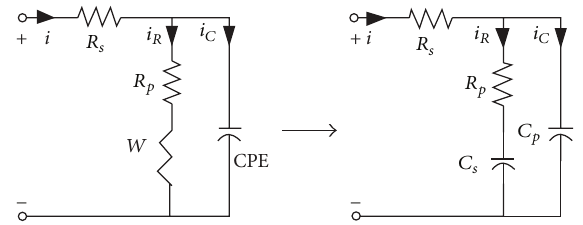
Figure 8: Equivalent electrical circuit for the limited diffusion